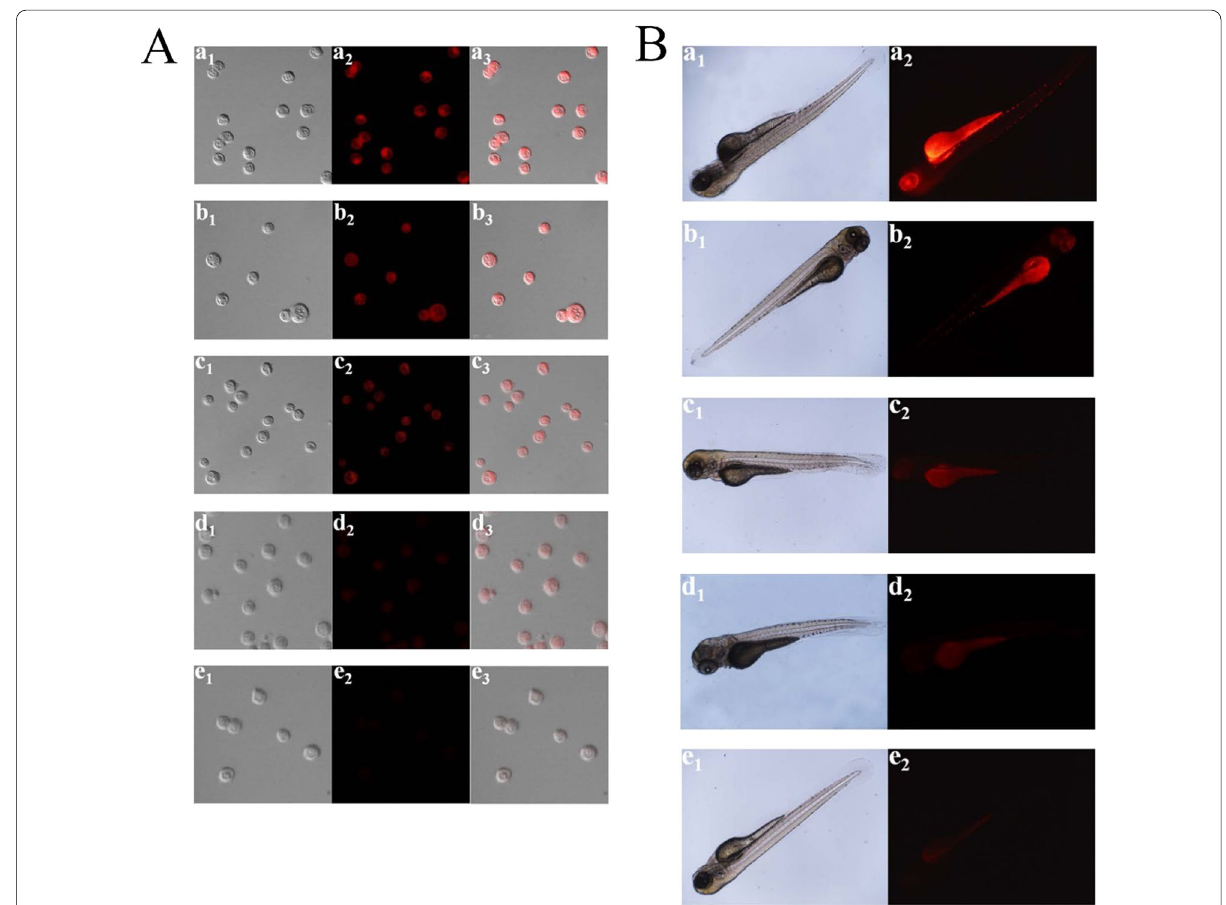
Fig. 3 A Confocal imaging of Pt 2 + in PC12 cells. (a1–e1) Bright field images. (a2–e2) Black field images of the CDs in PC12 cells with the different concentrations of Pt 2 + (0, 25, 50, 150, and 300 μM). (a3–e3) Overlay images. B Fluorescence imaging of Pt 2 + in ZF. (a1–e1) Bright field images. (a2– e2) Fluorescence images of the CDs in ZF with the various concentrations of Pt 2 + (0, 30, 60, 100, and 150 μM)